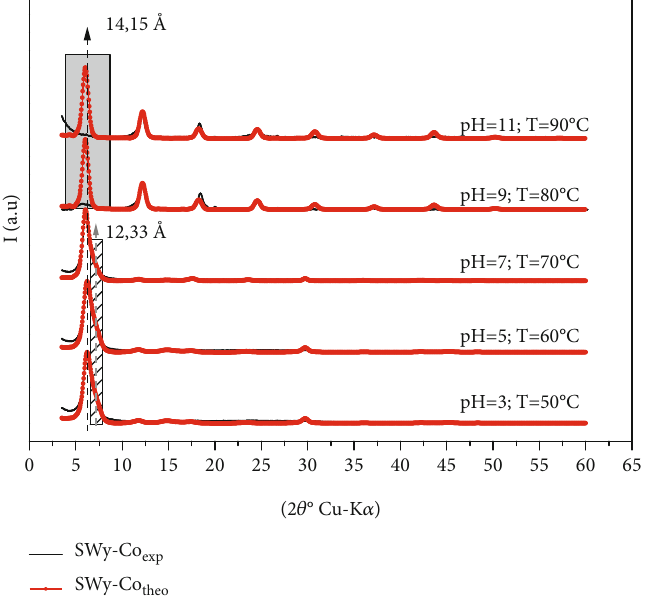
Figure 6: Best agreement between theoretical and experimental XRD pro fi les obtained in the case of SWy-Co.